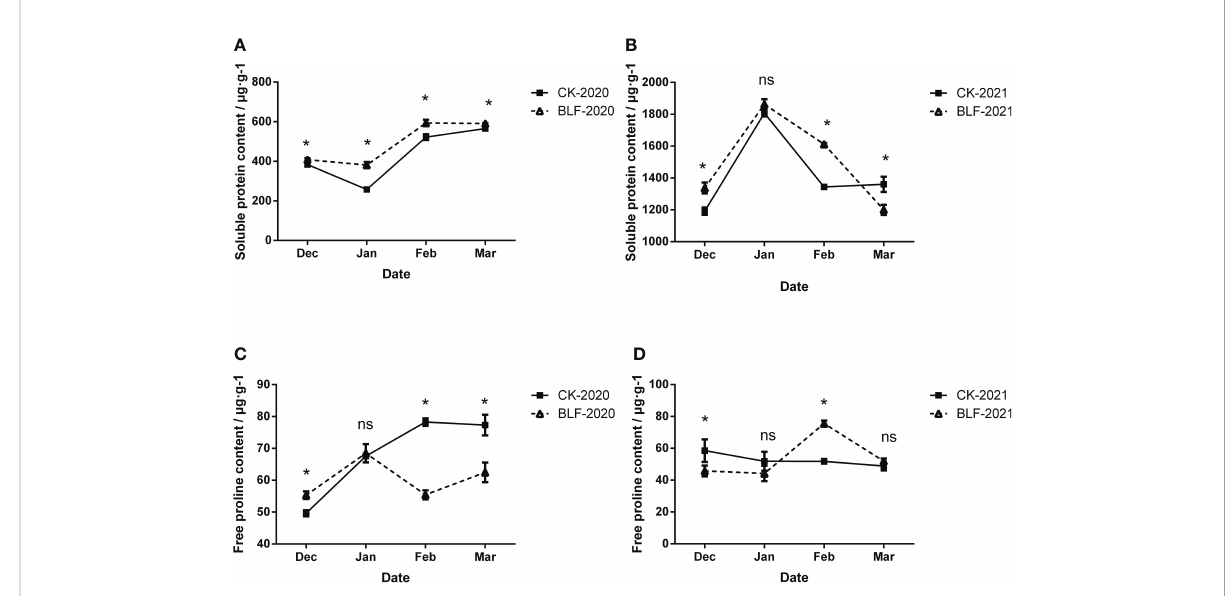
FIGURE 6 Effect of spraying BLF on the content of soluble protein (A, B) and free proline (C, D) on 2020 and 2021. “ * ” means that the average value of each parameter is signi fi cant between the two treatments (p<0.05), and ns means no signi fi cance by Duncan ’ s multiple range